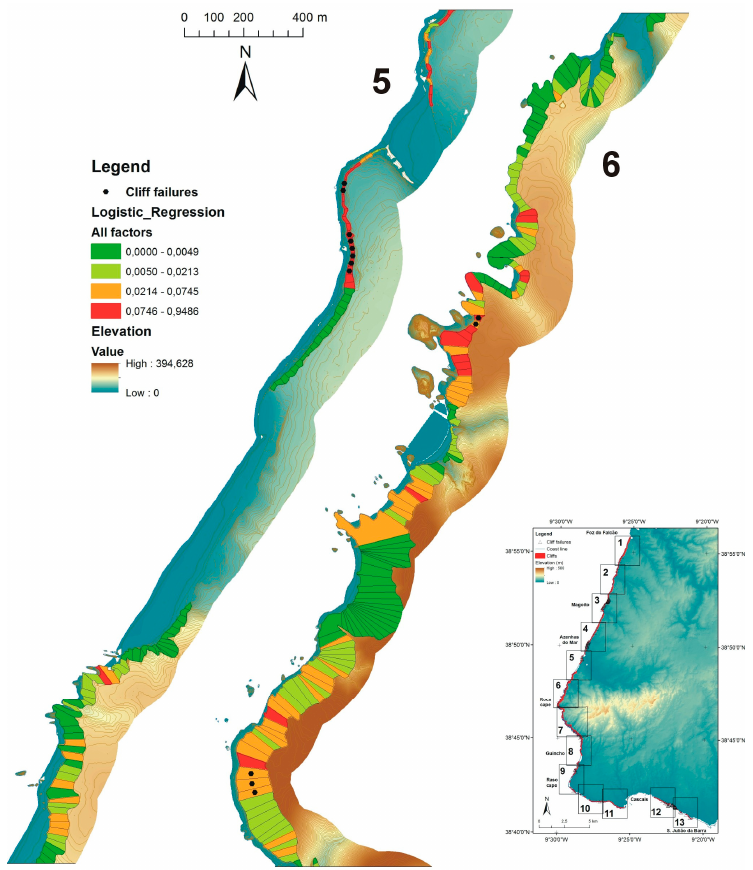
Figure 7. Susceptibility mapping (2/4) based on the logistic regression model with all factors, with indication (dot) of the terrain units with cliff failures, for cliff Sections 5 and 6, with general legend and localization map with numbered boxes indicating the extent of the cliff sections. Classification of logistic regression probability values in quantile-based classes. Contour line interval is 2 m.